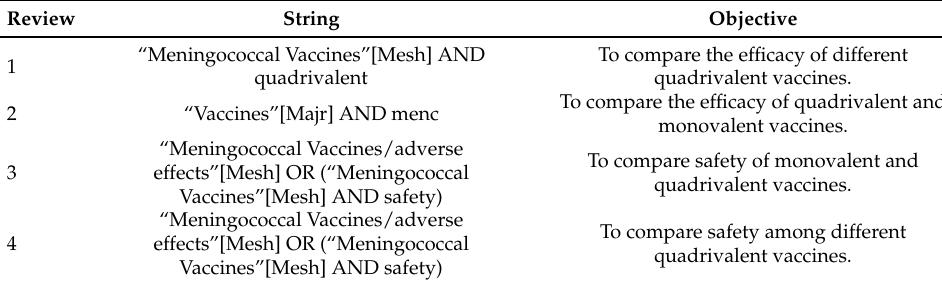
Table 1. Search strings and objectives of the different